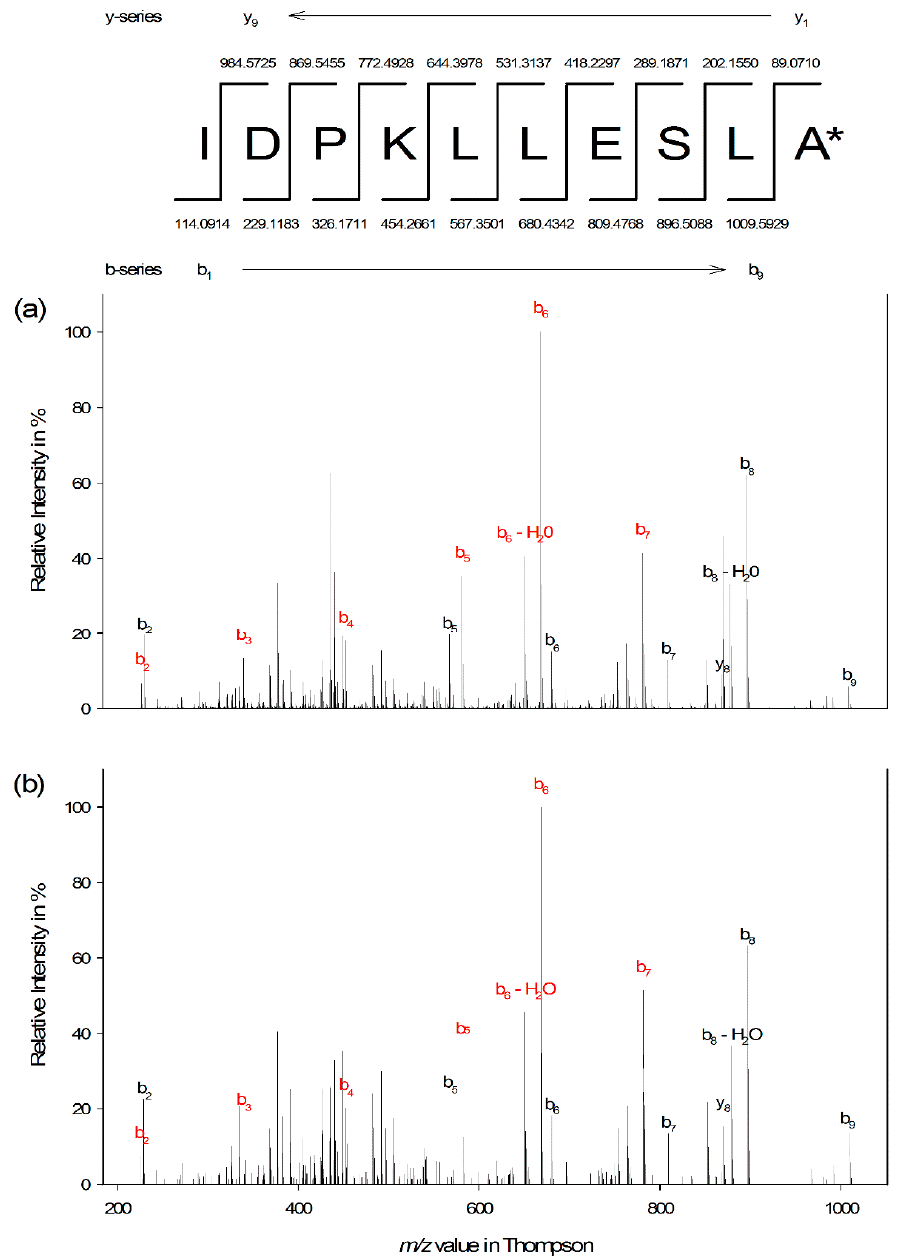
Figure 2. The tandem MS spectra of the natural (a) and synthetic (b) peptide U-MYRTX-MRArub1 showed highly similar fragmentation patterns. The spectrum is characterized by fragments of the native peptide (black) and the internal cleavage fragment PKLLESLA (red). Asterisk indicates C-terminal amidation. Spectra were acquired on a mircOTOF-QII instrument (Bruker, USA) by collision-induced dissociation (25 eV) with nitrogen as the collision gas.